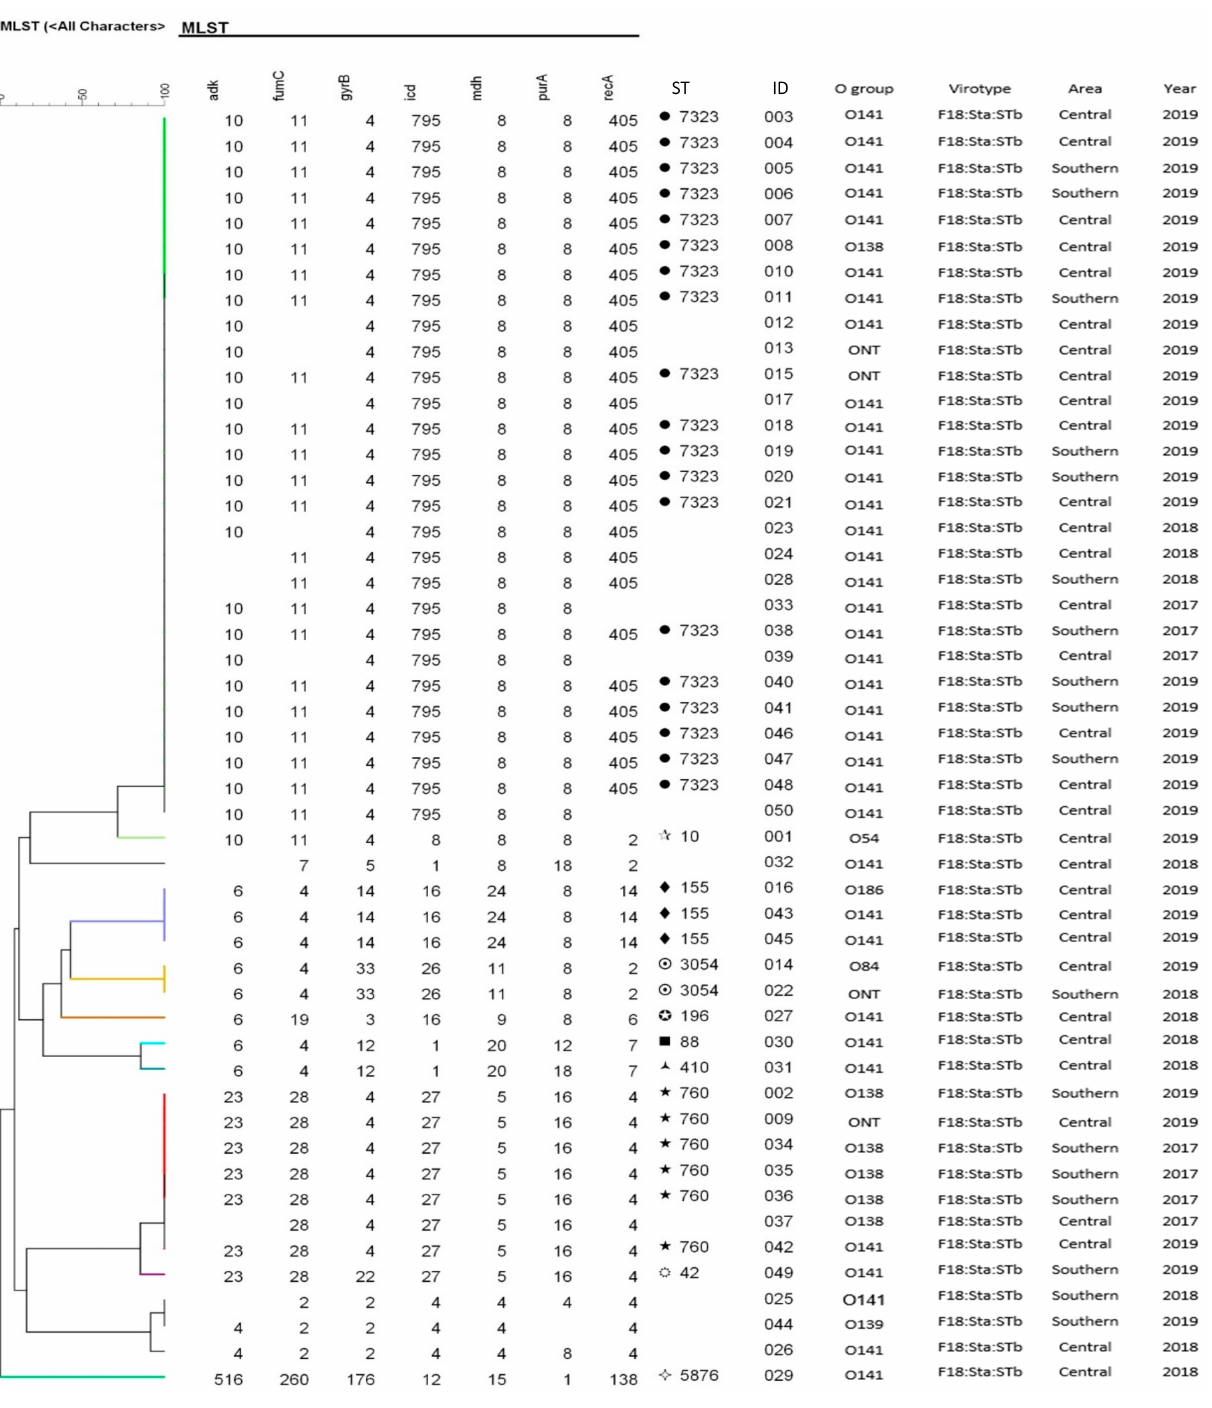
Figure 4. Maximum likelihood tree of sequence type (ST) of the F18:STa:STb detected in post-weaning piglets with O-serogroup, region detected, and